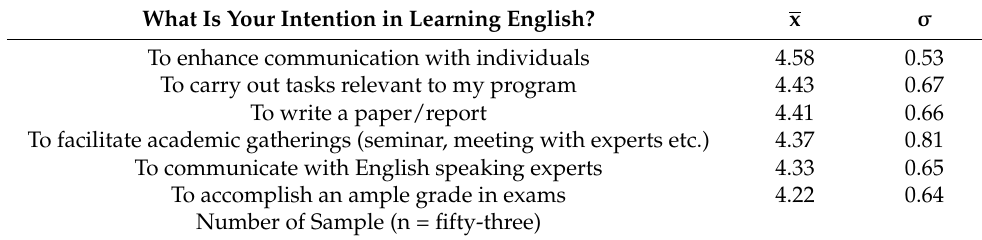
Table 1. Engineering Students’ Intention Learning English. What Is Your Intention in Learning